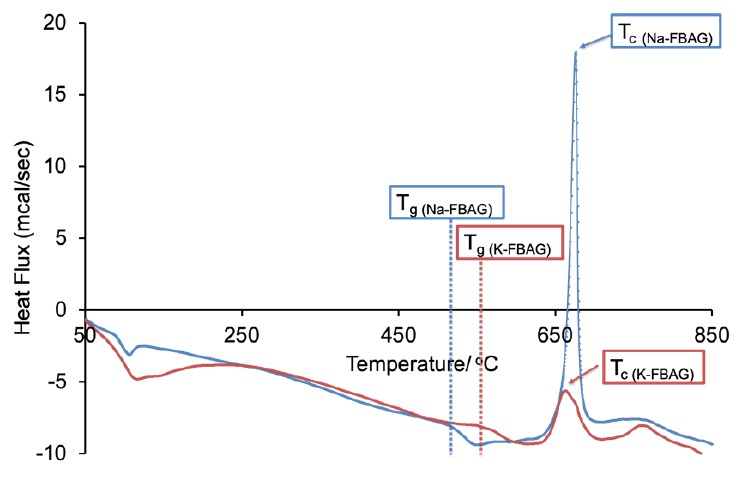
Figure 4. FTIR spectra of K-FBAG before and after immersion.